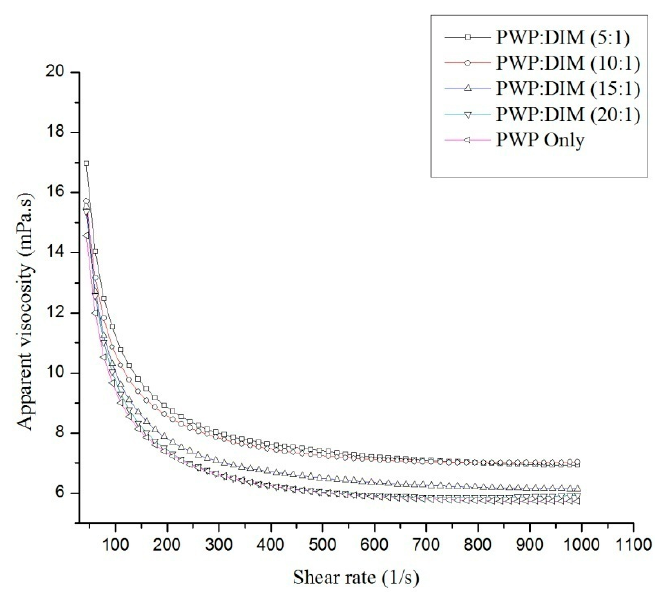
Figure 1. Behaviour of PWP and whey protein based DIM nanoparticles. Table 2. Infinite-shear-rate viscosity, consistency index and flow index were derived from the fitting results of flow curves with Sisko Model.